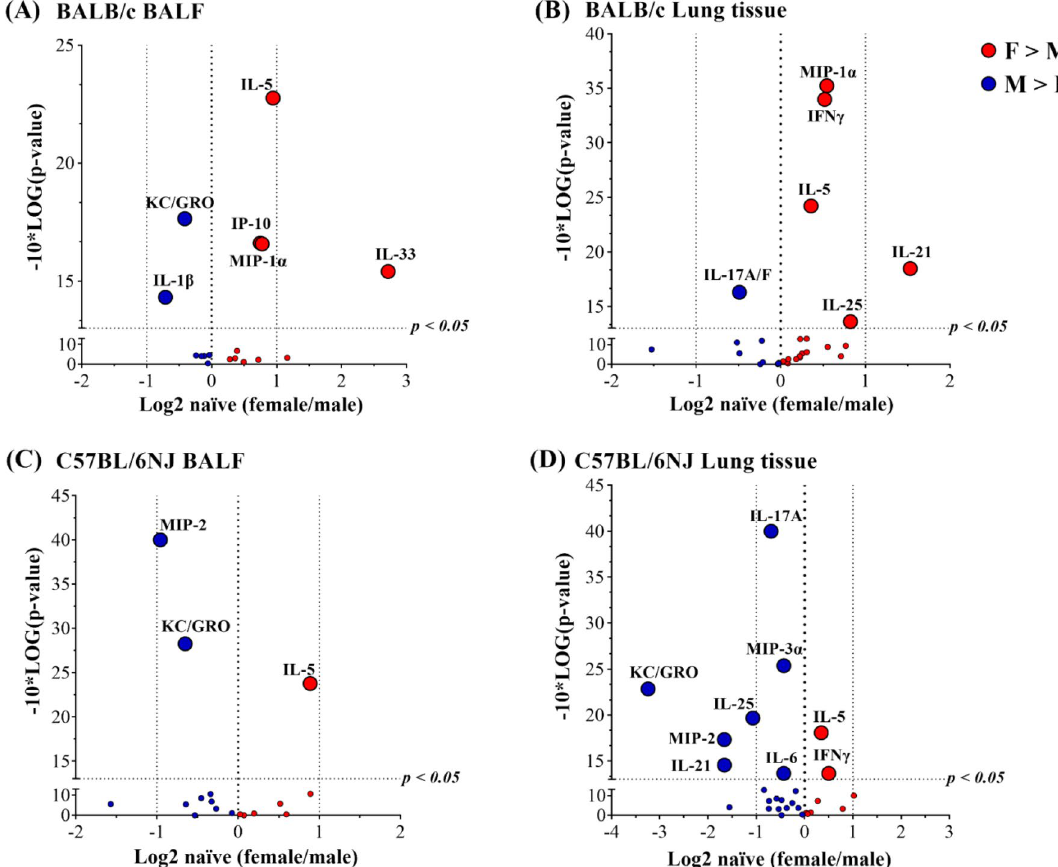
Figure 3. Sex-related differences in cytokine abundance in the lung of naïve BALB/c and C57BL/6NJ mice. A panel of 29 cytokines were measured by multiplex Meso Scale Discovery (MSD) platform in ( A ) BALF and ( B ) lung tissue lysates obtained from naïve BALB/c mice (n = 9 each, female and male), and ( C ) BALF and ( D ) lung tissue lysates obtained from naïve C57BL/6NJ mice (n = 10 each, female (F) and male (M) mice). Log2 values of average concentrations (pg/mL) of each cytokine were used for the volcano plots to examine the differences between female and male mice. Cytokine abundances that were significantly higher in females compared to males have positive values (shown in red), and those that were significantly higher in males compared to females have negative values (shown in blue), as represented on the x-axis of the volcano plots. Dotted lines represent a fold change of 2 (x-axis) and p < 0.05